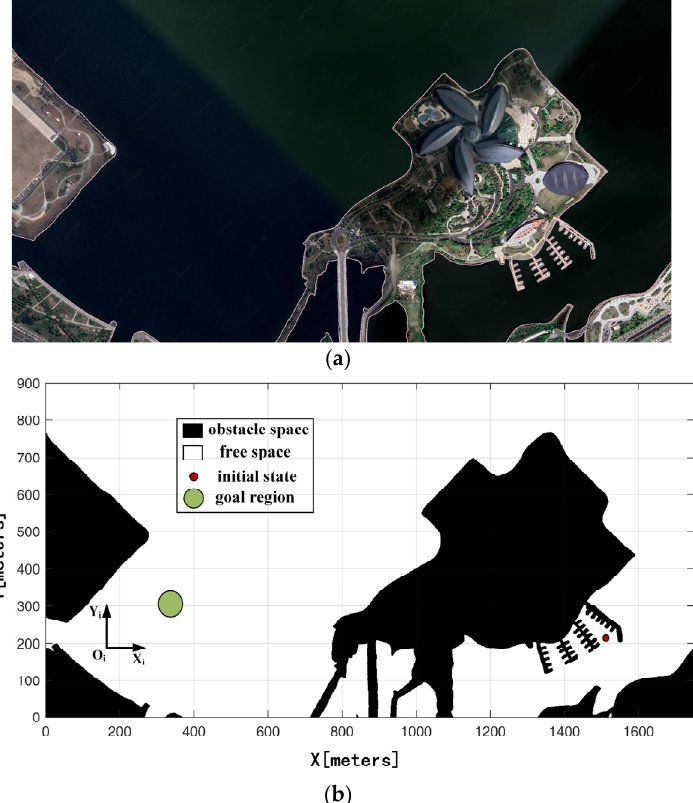
Figure 2. Conversion from the satellite image to binarization map: ( a ) the Dishui Lake partial (location: 30°53 ′ 34.51 ″ N, 121°55 ′ 52.59 ″ E, width: 1750 m, height: 900 m); ( b ) the binarization map.